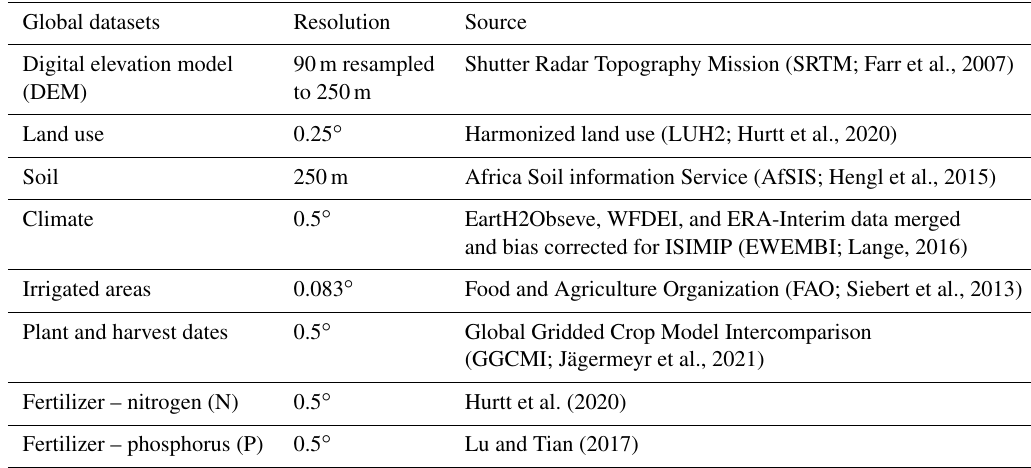
Table 1. Global datasets used for the model set-up.